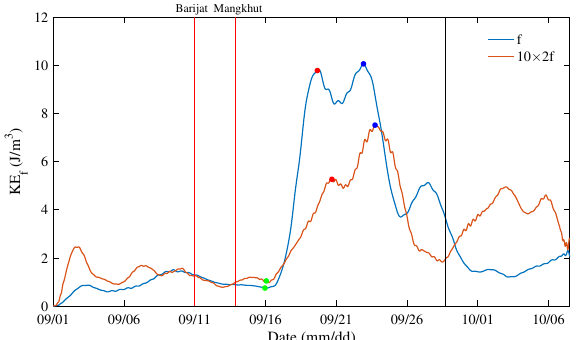
Figure 6. Depth-averaged NIKE and 10 times the KE in 2 f energy of band during the passage of typhoons Mangkhut and Barijat. The red vertical lines are same as Fig. 1. The black vertical line denotes the e-folding time of depth-averaged NIKE.